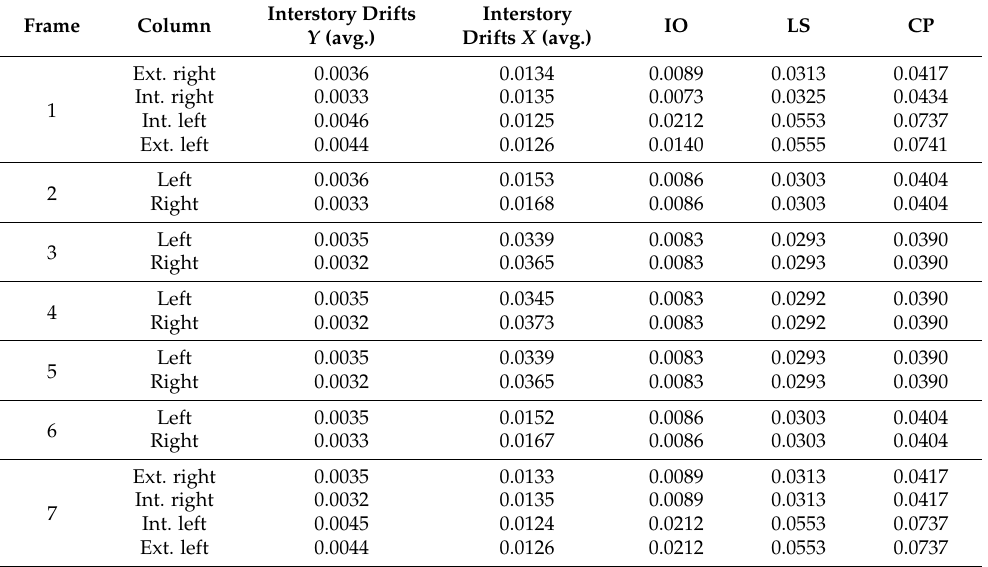
Table 7. Results of acceptance criteria for each column, using the average of the maximum interstory drifts for each